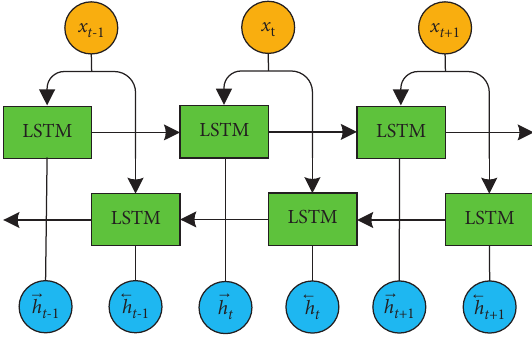
Figure 1: LSTM unit